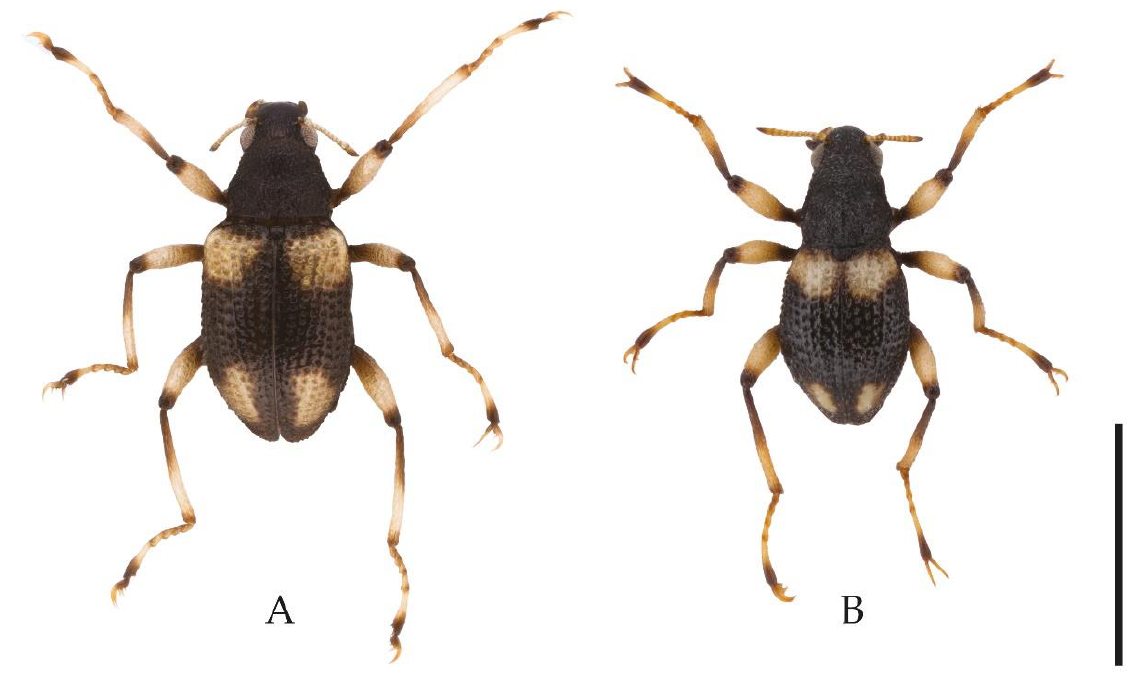
Figure 2. Dorsal habitus images of ( A ) Ancyronyx jhoanae sp. nov. and ( B ) A. tamaraw Freitag, 2013. Head (Figure 3A,B): HW: 0.26–0.29 mm (0.27 mm); ID: 0.19–0.20 mm (0.19 mm); labrum smooth with sparse, trichoid setae; clypeus and frons reticulate with longitudinal striae; frontoclypeal suture convex and conspicuous. Eyes moderately protruding. Anten- nae (Figure 3A) with 11 antennomeres, slender, slightly longer than head width. Genae reticulate with sparse pubescence. Gula microstriate; gular sutures distinct.